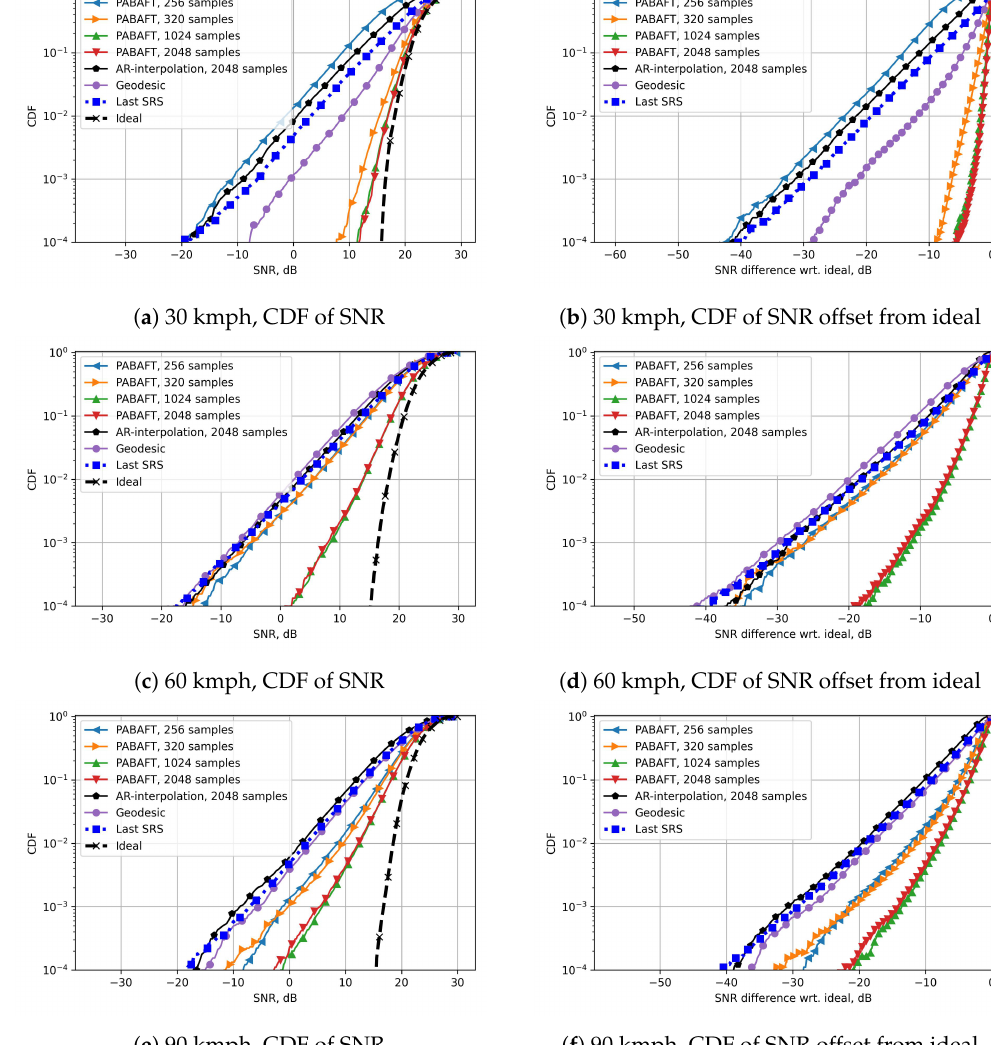
Figure 4. Link-level